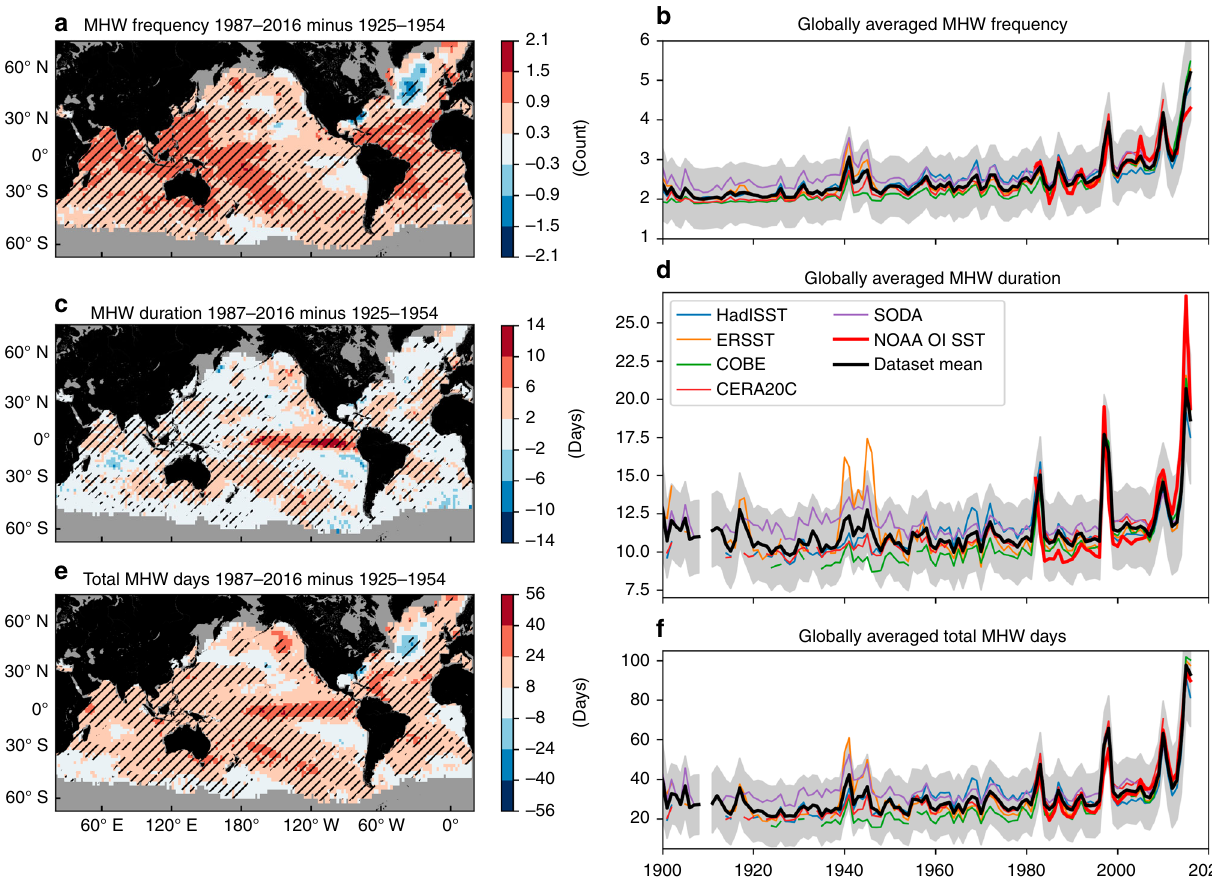
Fig. 5 Centennial-scale changes in marine heatwave proxies derived from monthly gridded sea surface temperature data sets. a , c , e Difference between 1925 – 1954 and 1987 – 2016 and b , d , f globally averaged time series of annual a , b marine heatwave (MHW) frequency, c , d MHW duration and e , f total MHW days based on monthly proxies derived from all proxy data sets (data set mean) over 1900 – 2016. In a , c , e , hatching indicates that all fi ve data sets agreed on the sign of the change (corresponding to 5% signi fi cance based on a binomial distribution) and grey areas indicate no data. The equivalent maps for each individual data set can be found in Supplementary Fig. 4. In b , d , f , globally averaged time series of MHW properties are shown for (thick red line) the NOAA OI SST 1982 – 2016 data, (thin coloured lines) the individual proxy data sets and (thick black line) the mean across all fi ve proxy data sets. The shaded areas show the 95% con fi dence intervals based on proxy model errors, averaged across the fi ve data sets (taking into account temporal